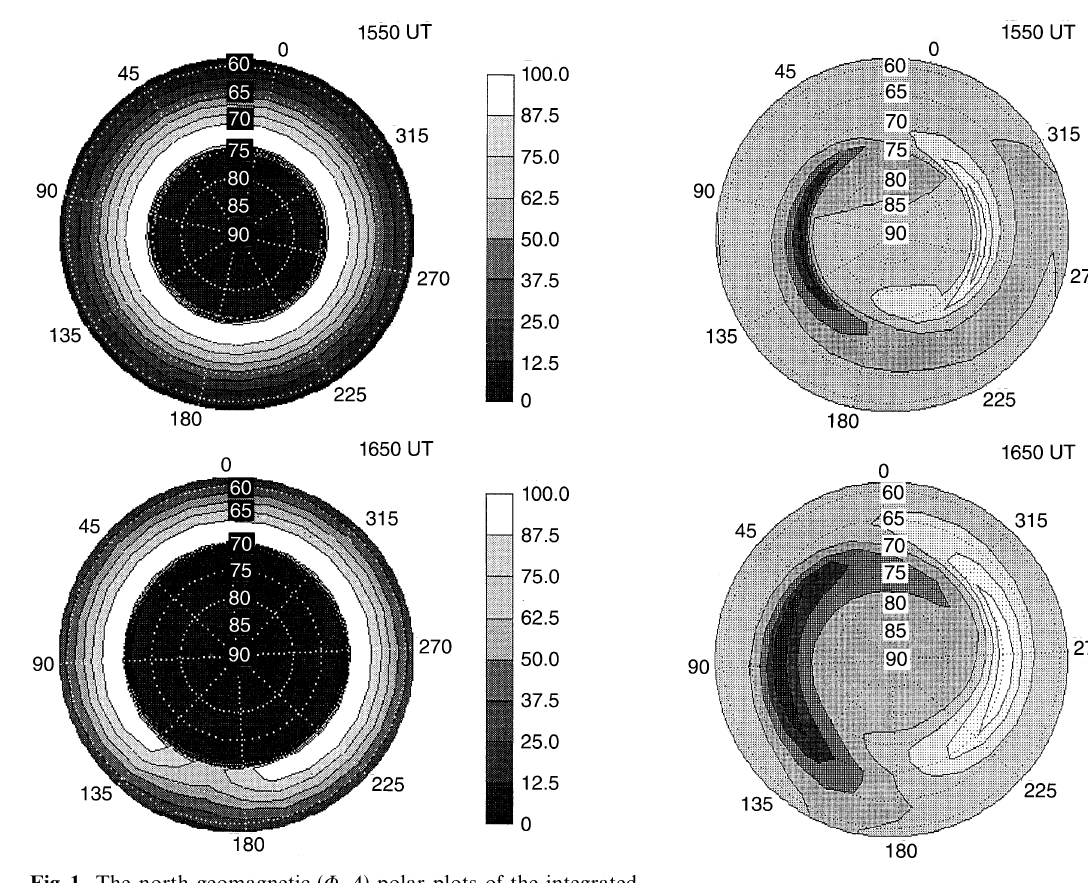
Fig. 2. The geomagnetic ( (cid:85) , (cid:75) ) polar plots of the calculated electric- field potential (kV) in the northern high-latitude ionosphere at the growth phase ( top ) and at the expansion phase ( bottom ) of the substorm; the Sun position is at the top of the